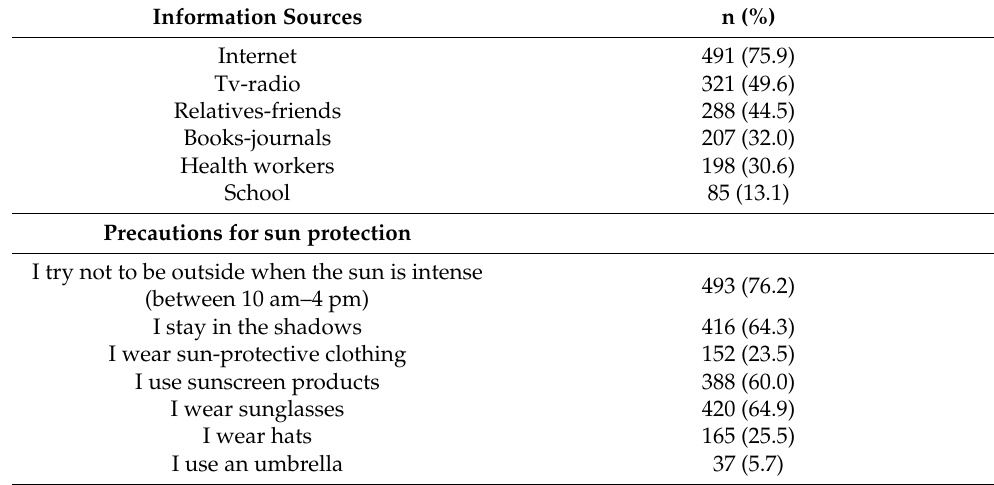
Table 2. The information sources of participants about skin cancer and their behaviors of sun